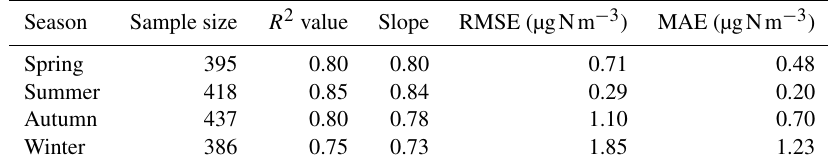
Table 2. The cross-validation result of NO